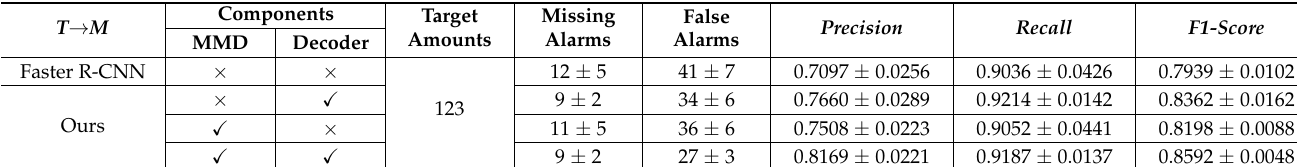
Table 4. Ablation results of our method on the miniSAR dataset.